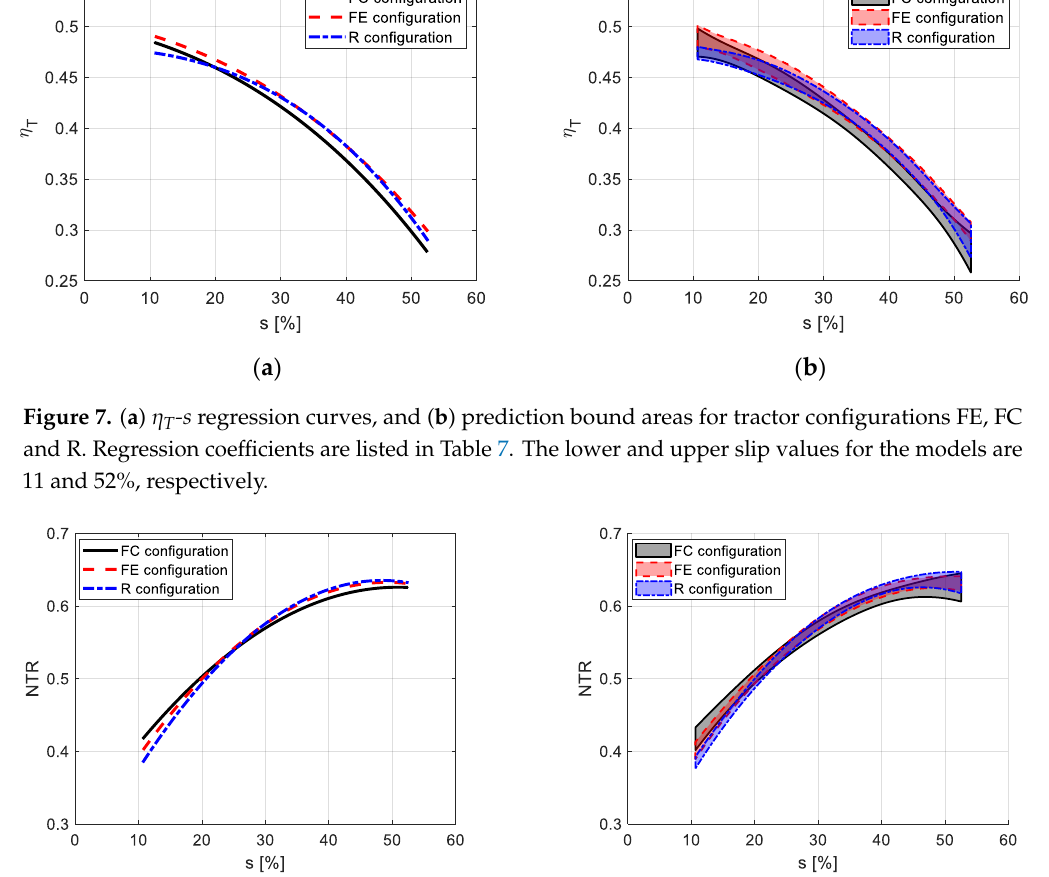
Figure 8. ( a ) NTR-s regression curves and ( b ) prediction bound areas for tractor configurations FE, FC and R. Regression coefficients are listed in Table 8. The lower and upper slip values for the models are 11 and 52%, respectively. Table 9. Coefficient values for the NTR-η T regression model (R3).